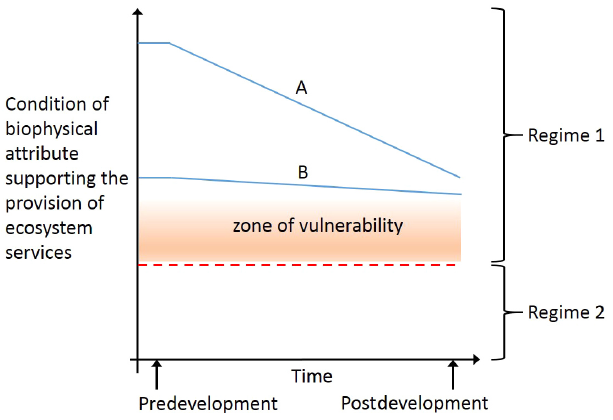
Fig. 2 . Illustration of the way in which differences in the trajectory of biophysical attributes during the period of urban development influence the assessment of natural capacity, with system A assessed as having lower natural capacity than system B postdevelopment. Regime 2 represents a system state with reduced ecosystem service